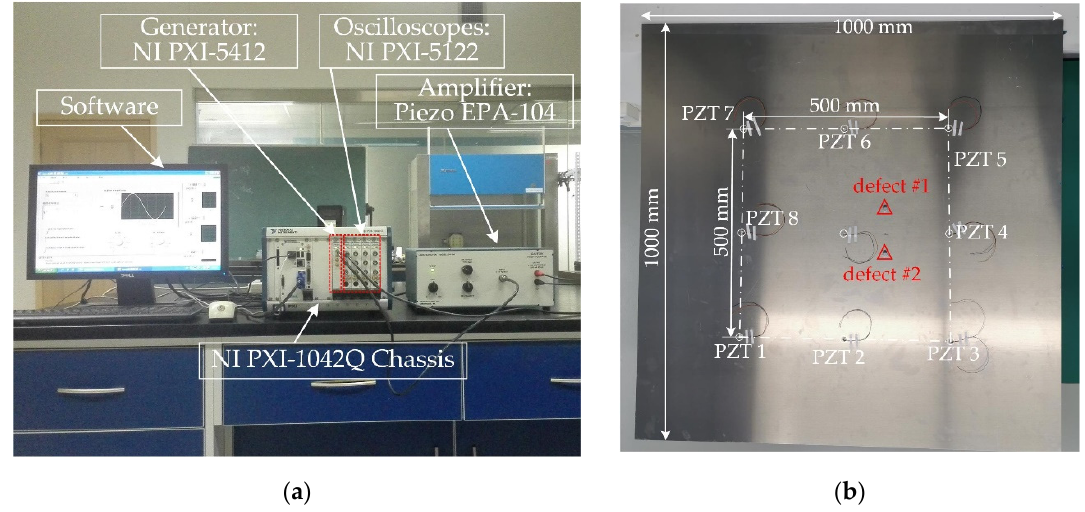
Figure 6. ( a ) Photograph of the experimental setup; ( b ) the experimental aluminum plate with